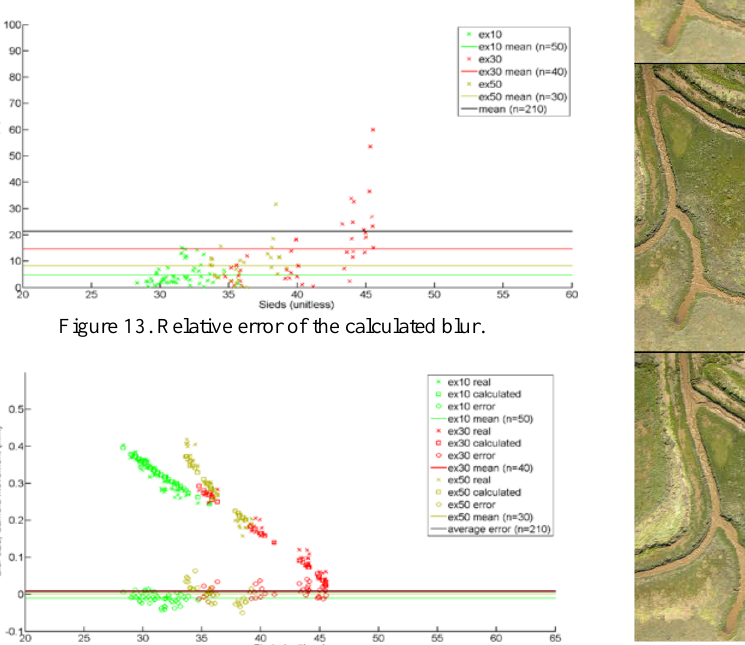
Figure 16. Blur detection result for image